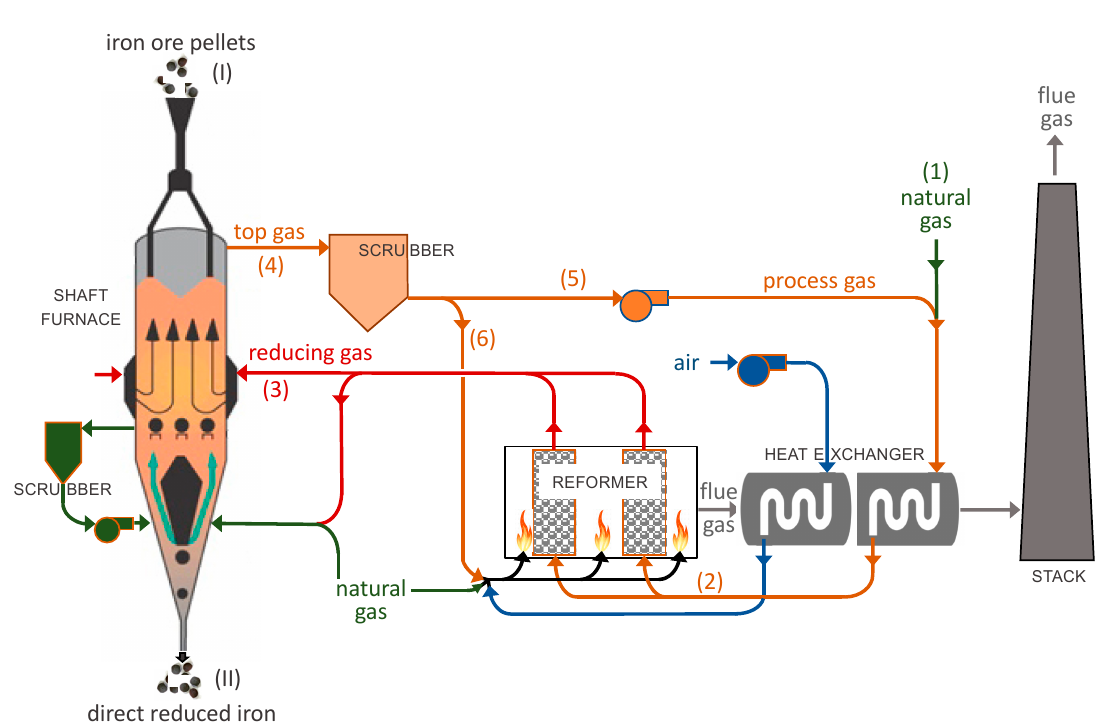
Figure 1. Scheme of the MIDREX-type direct reduction process.